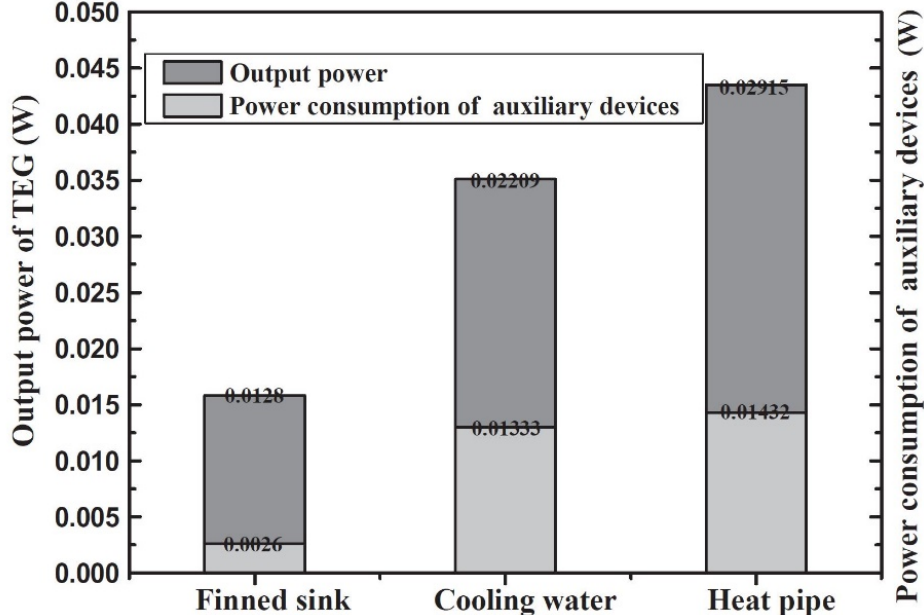
Figure 6. Net output power, output power and power consumption of three different cooling methods. Reprint with permission [56]; Copyright 2021, Elsevier.